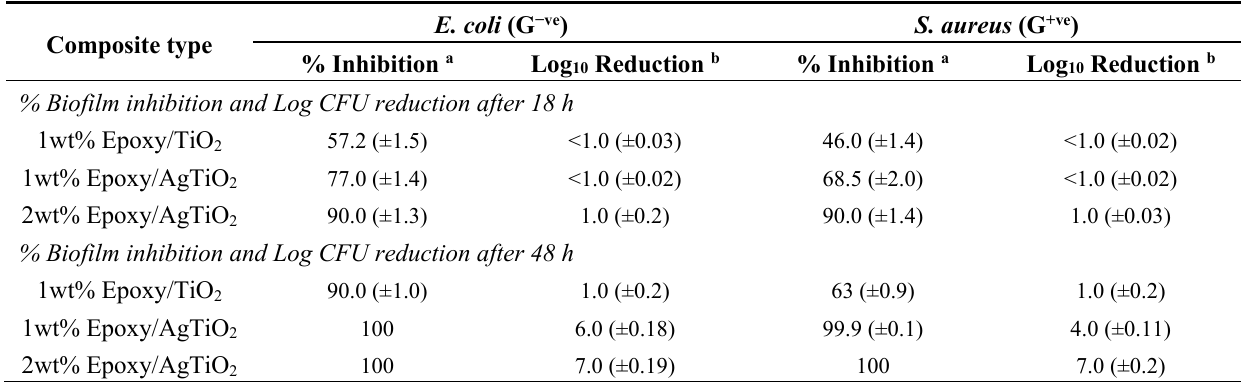
Table 2. Different nanocomposite materials and their antibiofilm efficacy for 18 and 48 h irradiation